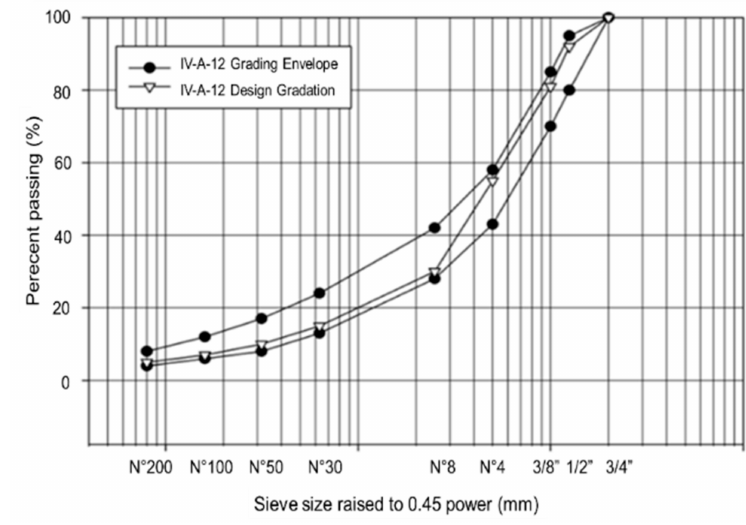
Figure 2. Aggregate gradation of the IV-A-12 reference asphalt mixture.